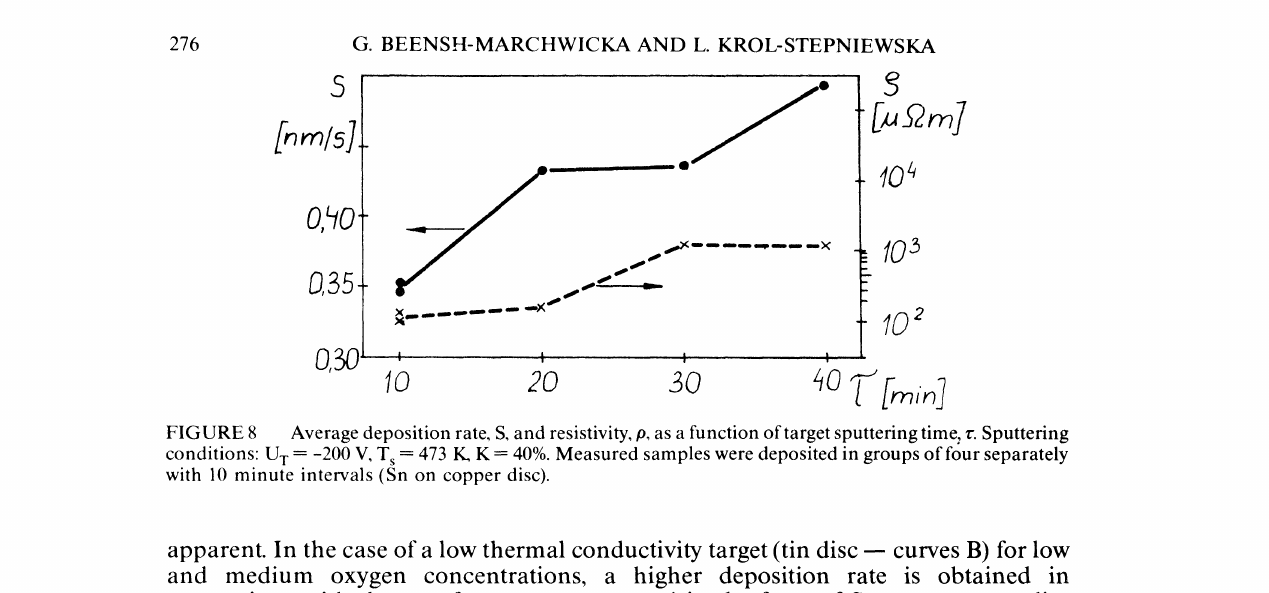
Average deposition rate, S, and resistivity, 0, as a function of target sputtering time., v. Sputtering conditions: U T -200 V, T 473 K, K 40%. Measured samples were deposited in groups offour separately with 10 minute intervals (Sn on copper disc).